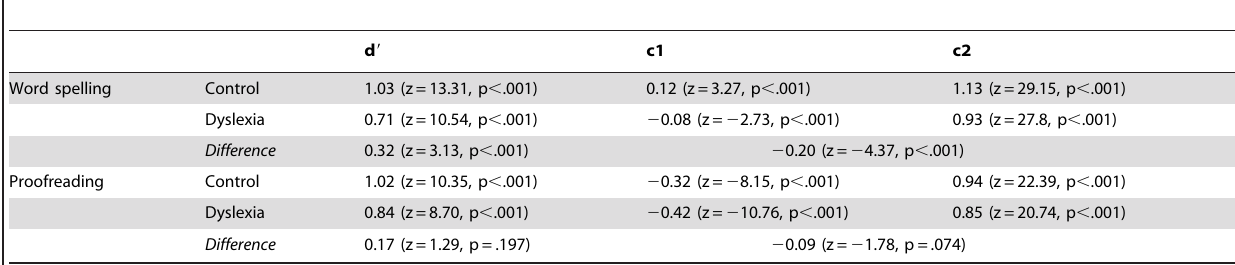
Table 3. Results of the Signal Detection Theory Analysis for the Word Dictation and Proofreading tasks.